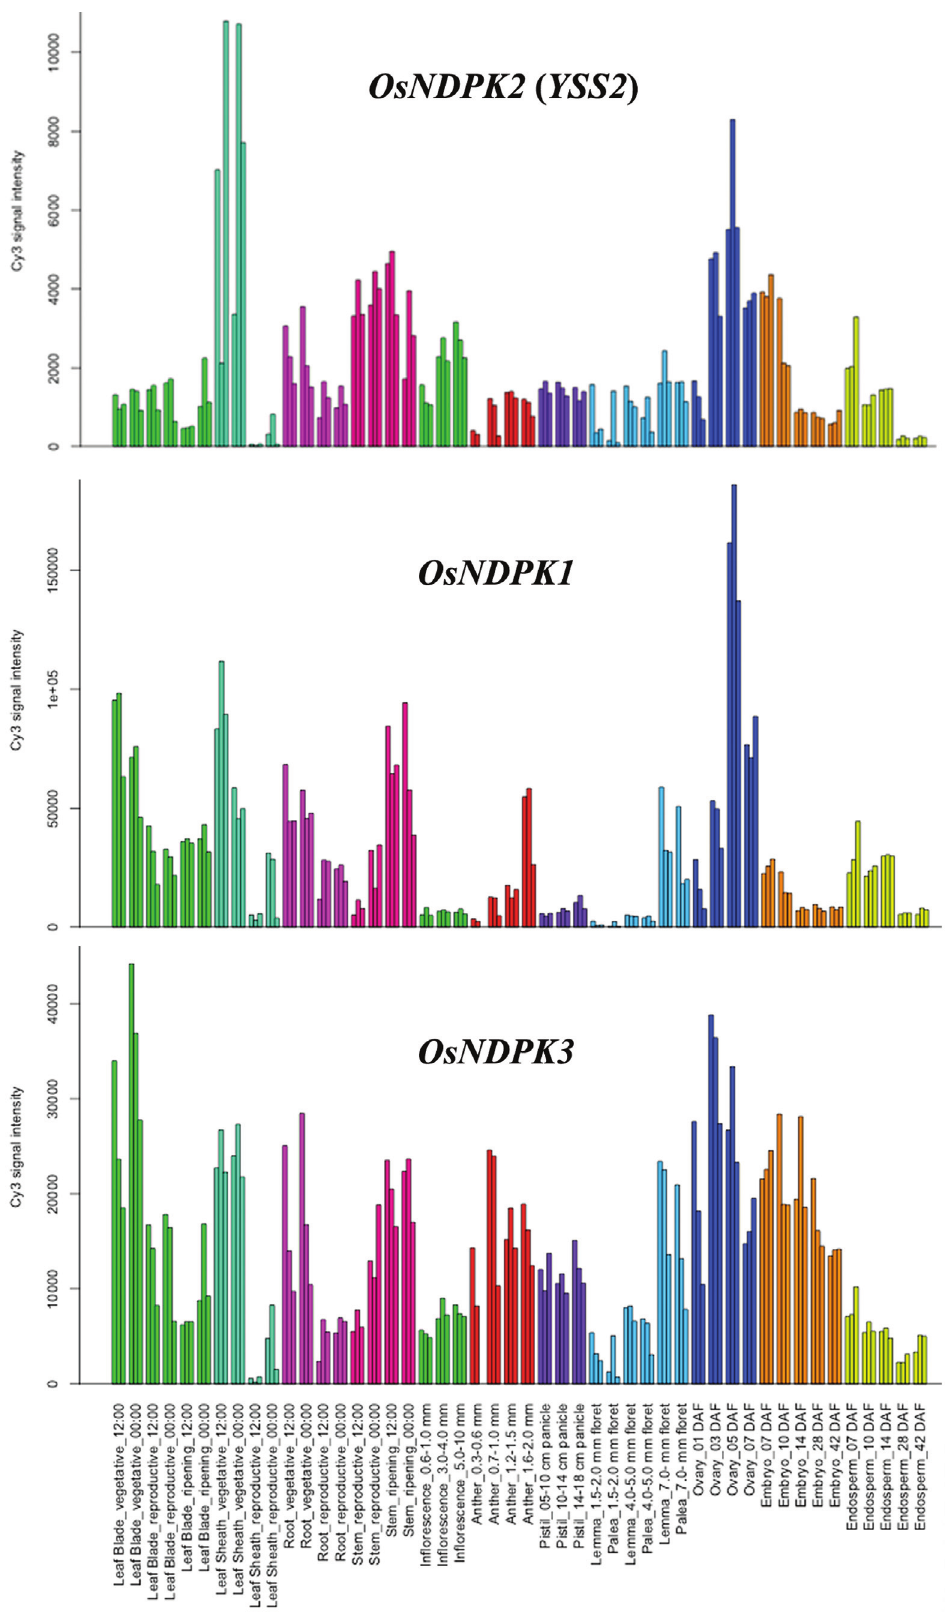
Figure 5 - Expression analysis of YSS2 , OsNDPK1 and OsNDPK3 at various growth stages. Data were collected from the rice expression profile data- base, RiceXPro.